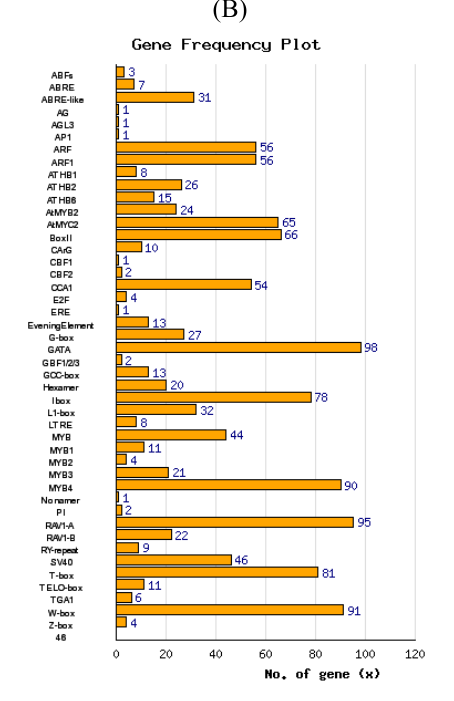
Figure 4. Known cis- element analysis of (A) SPL genes and (B) genes co-expressed with SPL